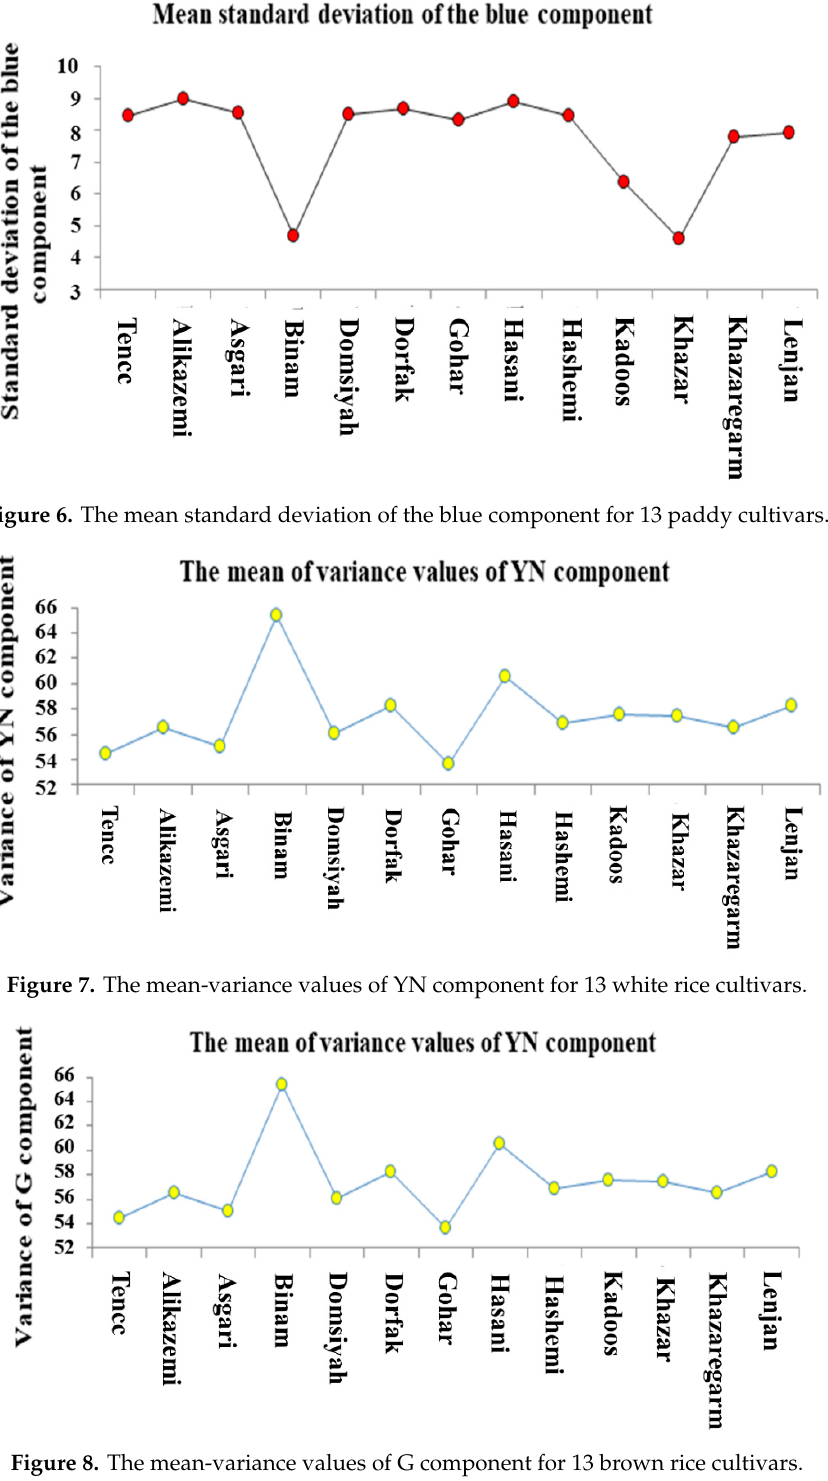
Figure 8. The mean-variance values of G component for 13 brown rice cultivars.